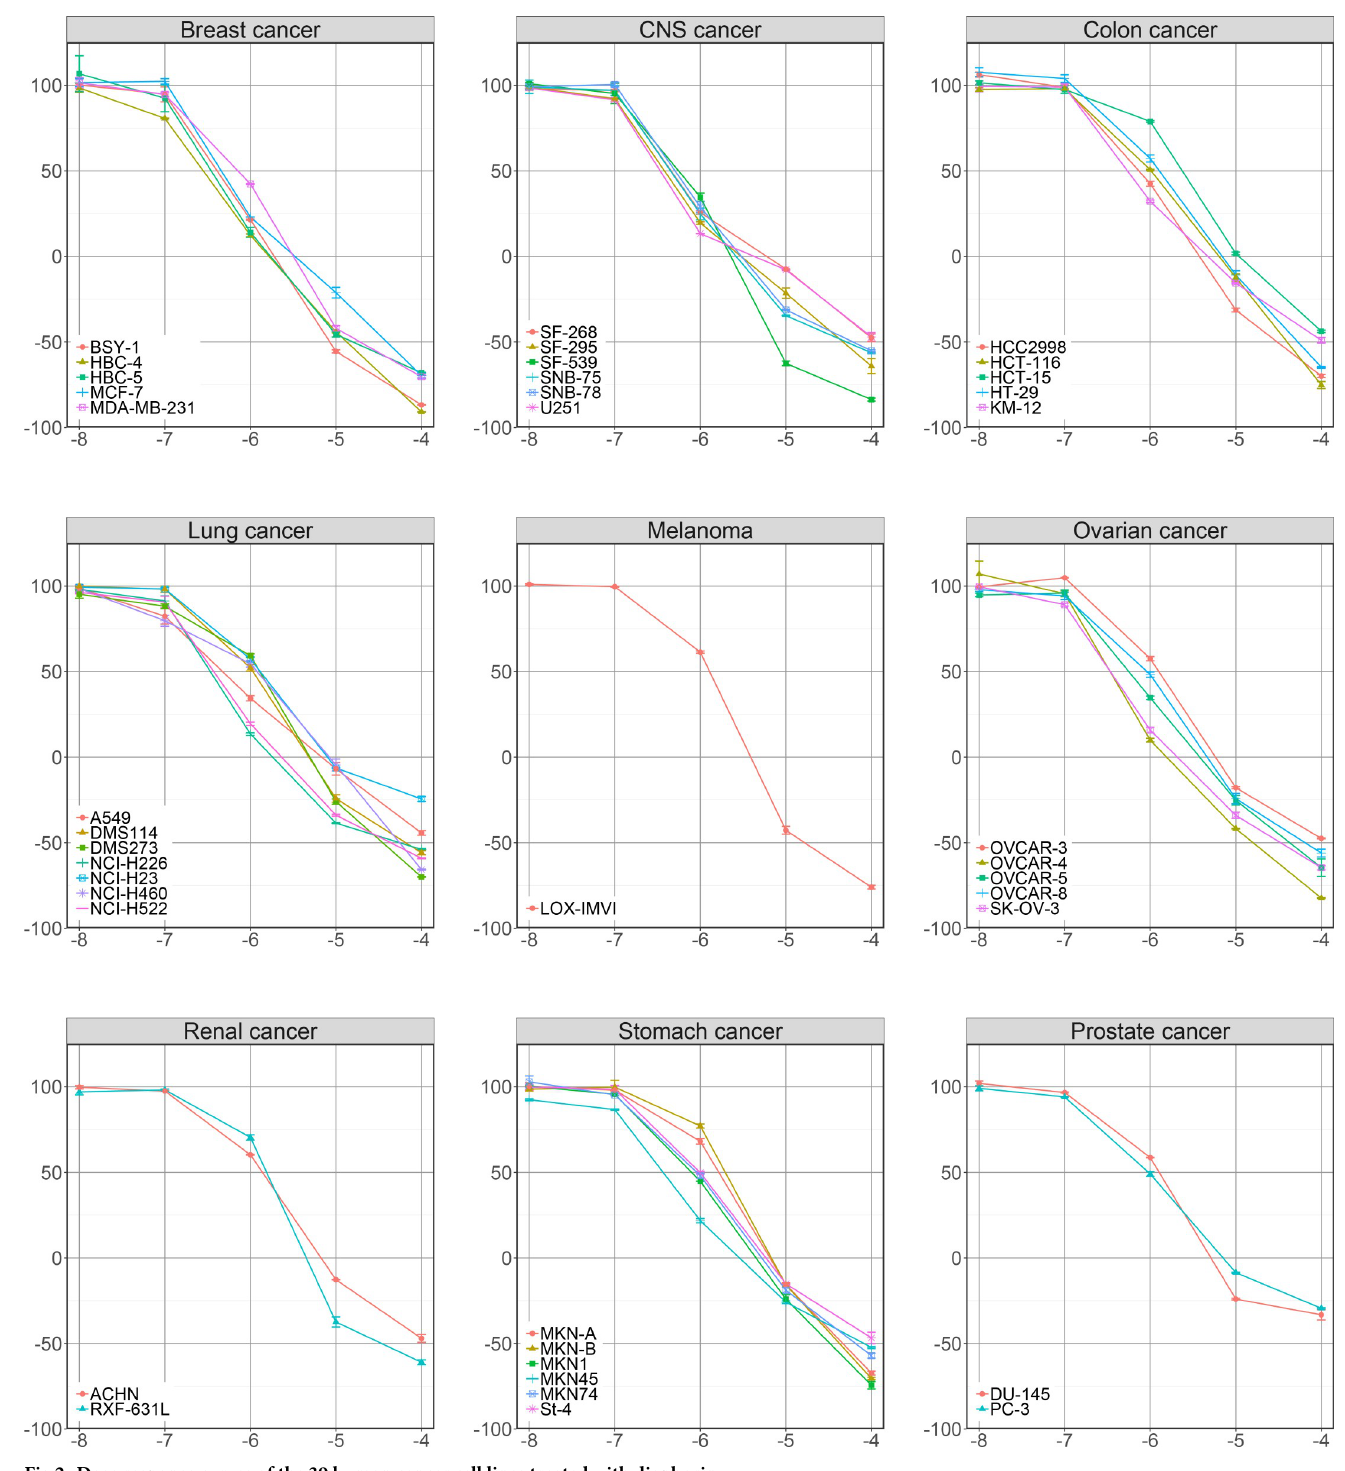
Fig 2. Dose response curves of the 39 human cancer cell lines treated with diaphorin.